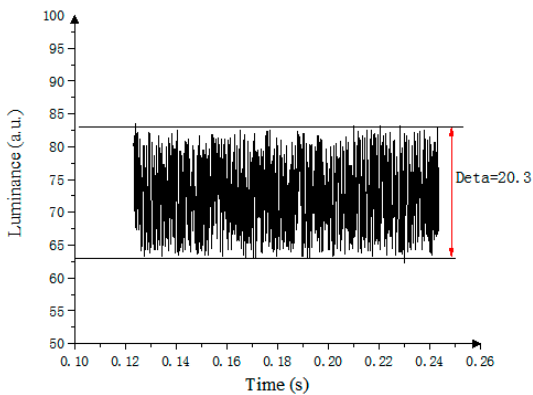
Figure 10. The oscillation characteristic of the oil in EWDs using PWM.